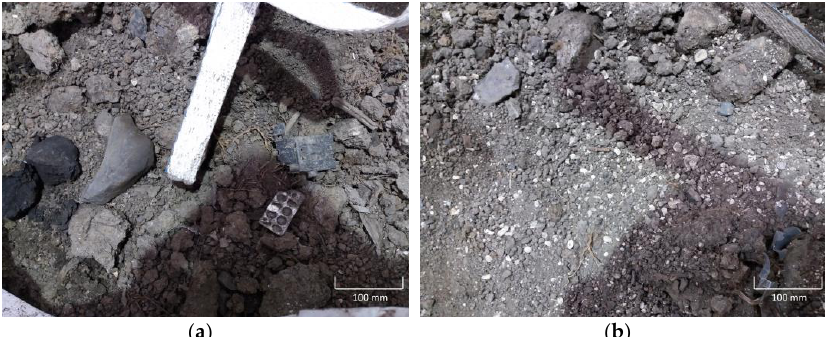
Figure 9. NLS river sediment. ( a ) Presence of exogenous like large granulates or medication package; ( b ) presence of granulates.